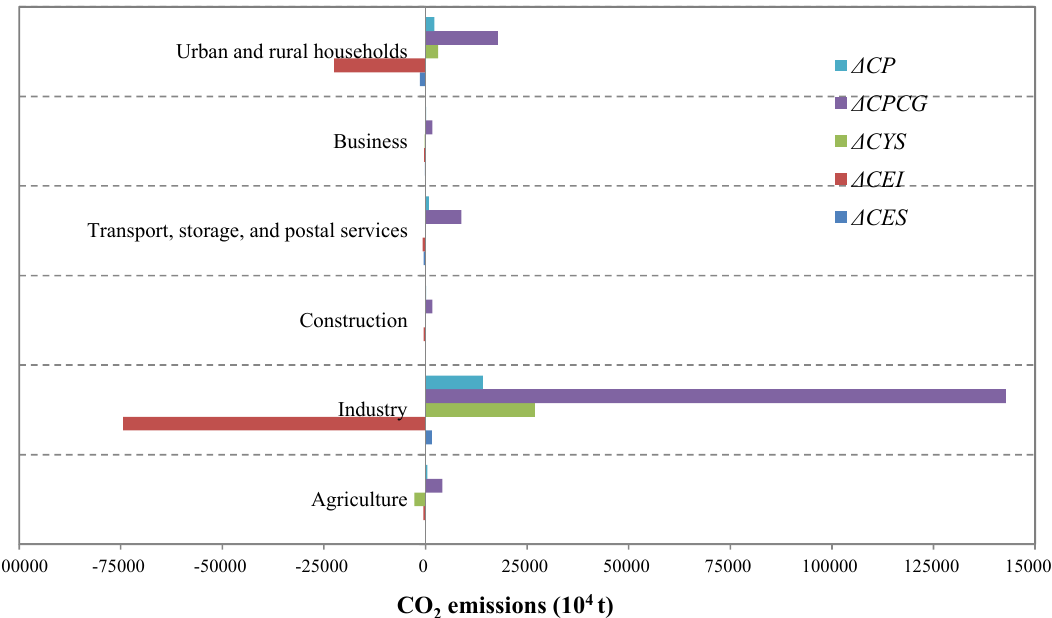
Figure 6. Cumulative contribution value of influencing factors of CO sectors from 1985 to